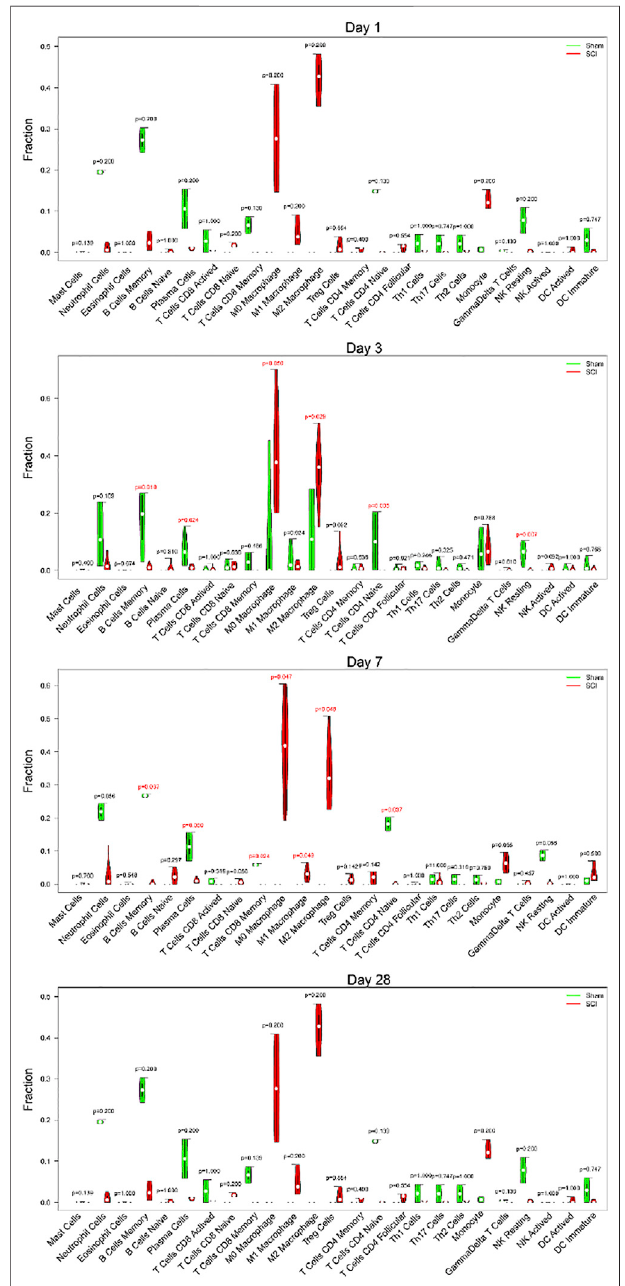
FIGURE 7 | Different time points of immune cell in fi ltration. The violin diagram exhibited the ratio of immune cells at different time points (1, 3, 7, 28 days of post-injury). The red represents the SCI group, and the green represents the sham